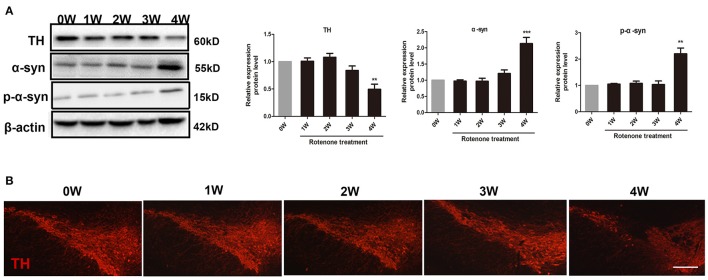
Progressive increase in α-synuclein pathology and decrease in tyrosine hydroxylase (TH) neurons in rotenone-treated mice. (A) Representative blots of α-syn, Ser129 α-syn (p-α-syn), and TH in the midbrain from rotenone-treated mice. (B) Representative photomicrographs of mesencephalic sections immunostained for TH in rotenone-treated mice. Scale bar = 500 μm. Data are expressed as means ± SEM of at least 3 mice, **p < 0.01, ***p < 0.001 vs. 0W.